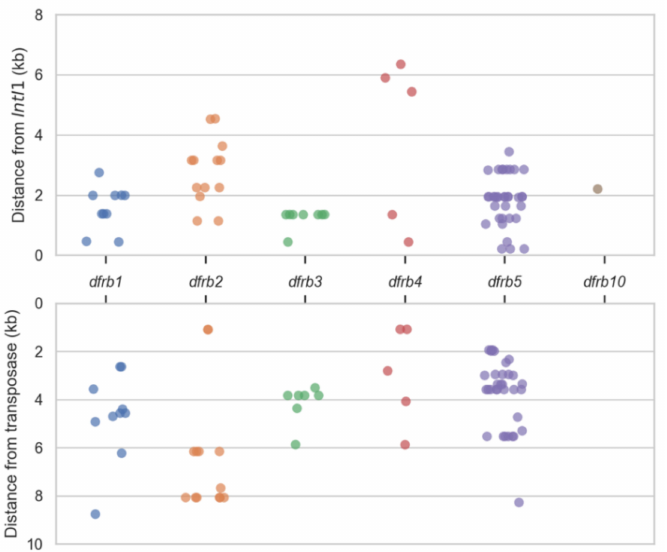
Figure 3. Distance between dfrbs and genes associated with genomic mobility. Top panel: distance between the dfrbs that are downstream a class 1 integrase. Bottom panel: distance between dfrbs and the closest transposase. Each dot represents one dfrb